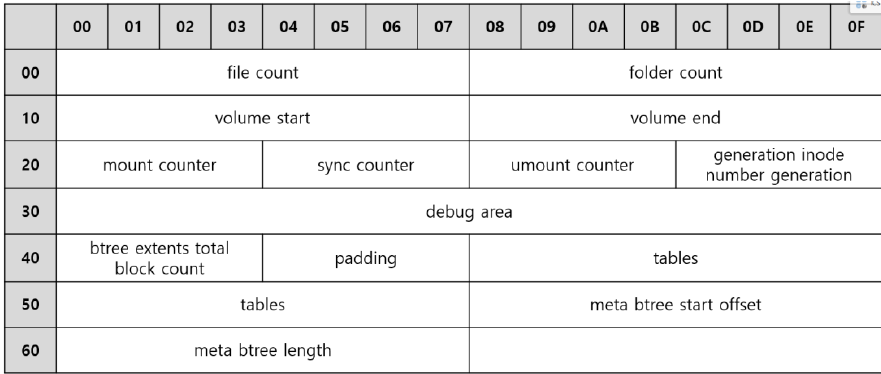
Figure 6. VDFS extended superblock structure in form of hex value.